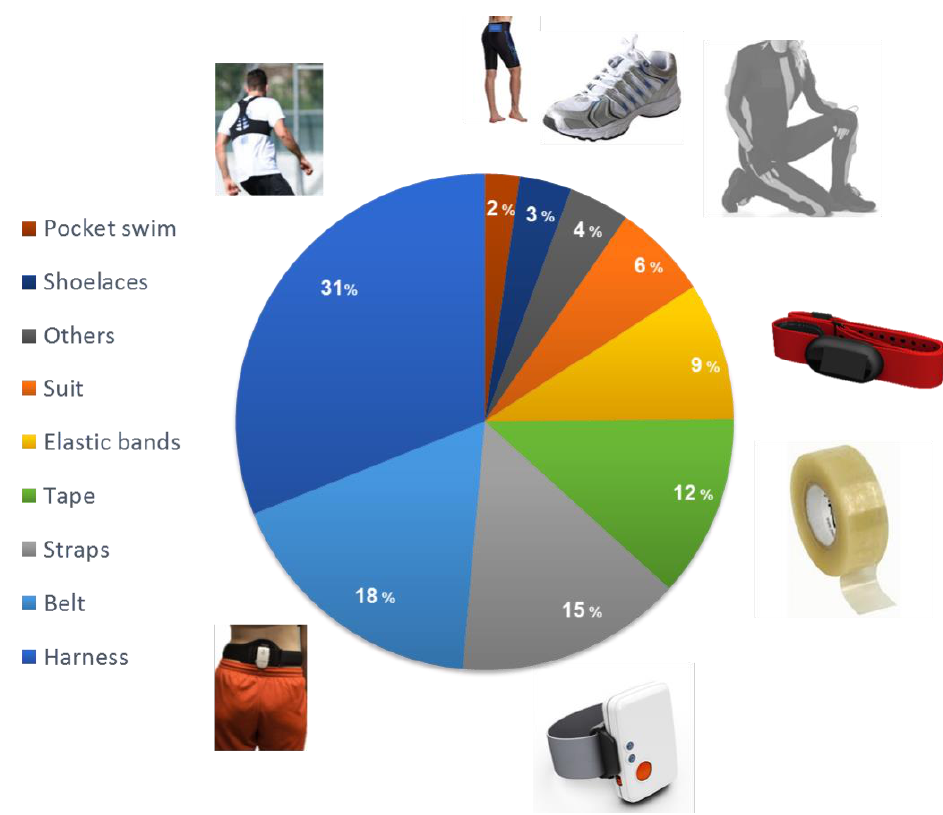
Figure 3. Device fixing mean in percentage (%) of the total papers, excluded those not specifying the fixing modality.